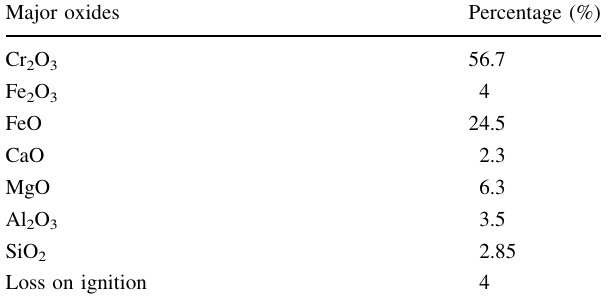
Table 2 Major oxides of the refined chromite sample